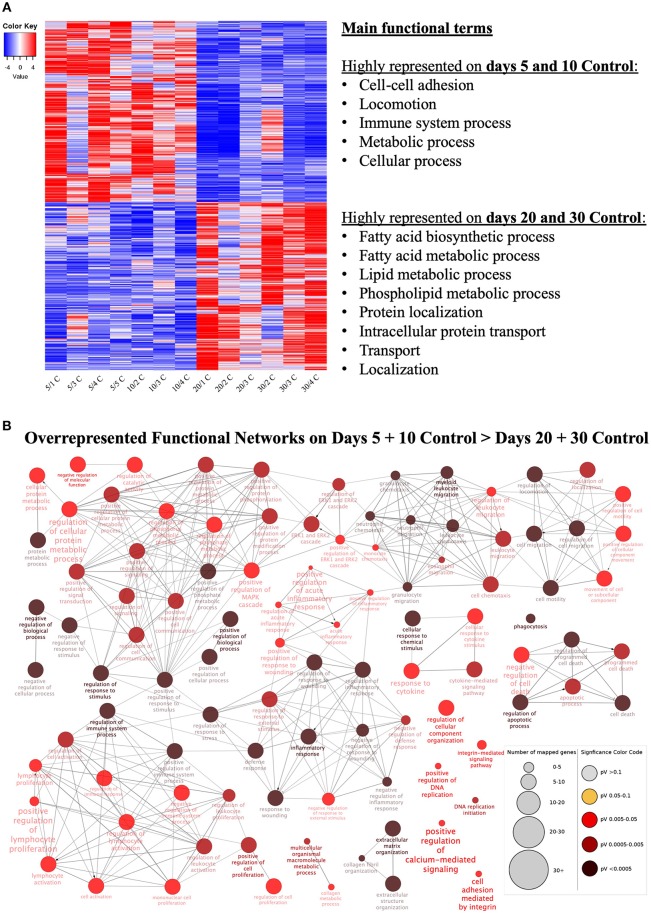
Functional categorization of differentially expressed genes (DEGs) affected at selected time points (contrast “days 20+30 control over days 5+10 control”). (A) Heatmap of 3,484 DEGs in the contrast “days 20+30 over days 5+10 control.” Gradient of high to low expression of each gene relative to average expression is indicated by red to blue colors. 1,803 genes were more highly expressed in early (days 5 and 10) CL stages whereas 1,681 genes were more highly expressed in mid-diestrus (days 20 and 30) stages (P ≤ 0.01, FDR ≤ 0.1). Representative overrepresented functional terms in each group of upregulated genes are listed (statistical details are provided in the text and Supplemental Table 3). Entire list of DEGs is provided as Supplemental Table 1. (B) Functional networks found for downregulated DEGs from the contrast “days 20+30 control over days 5+10 control.” Overrepresented functional terms of days “5+10 control” are shown. Redundant or non-informative terms were removed and the networks obtained were manually rearranged. Number of mapped genes is indicated by the node size, while significance of functional terms is denoted by node color (represented in legend at the right bottom corner). Networks more highly represented on days 5 and 10 control (developing gonadotropin-independent CL) were related to immune function, extra-cellular matrix (ECM), intracellular signaling and apoptosis.